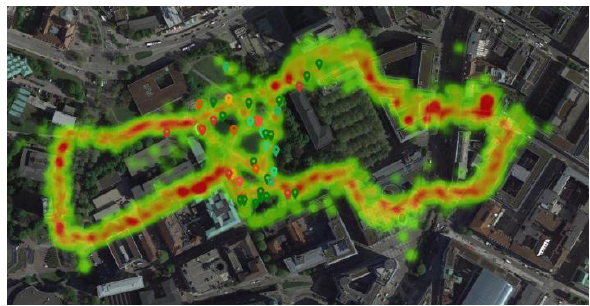
Figure 5. heat map of heart rate (all